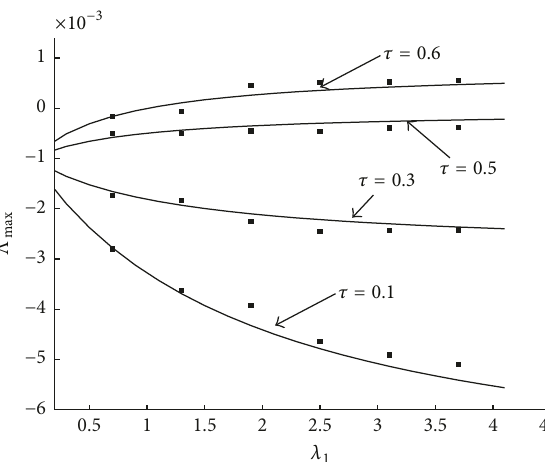
Figure 1: The largest Lyapunov exponent Λ max as function of transition rate 𝜆 1 . The lines are obtained from numerical solution of (37) while the symbols are obtained from direct simulation of original system (26).